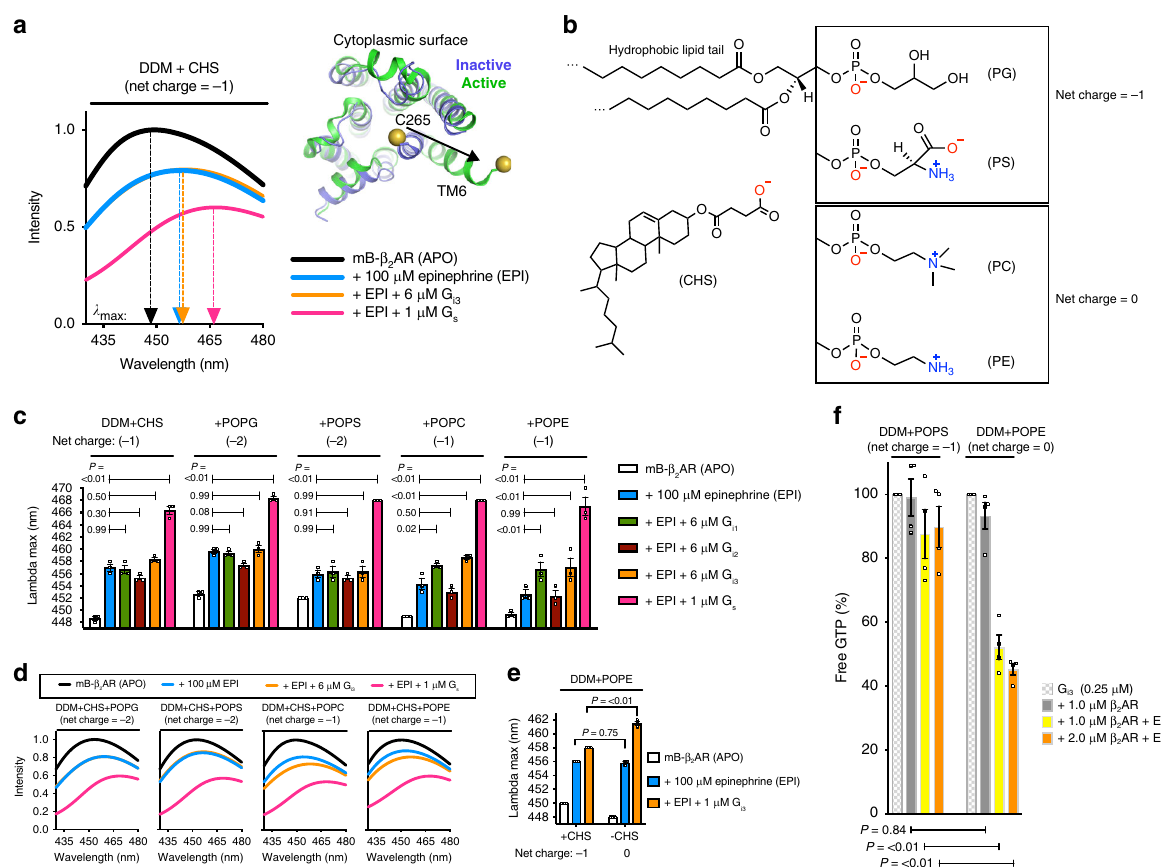
Fig. 1 Negatively charged lipids inhibit β 2 AR − G i coupling in detergent. a mB − β 2 AR emission spectra in DDM + CHS micelles (5:1 DDM:CHS mole ratio) in the absence of epinephrine (APO) and in the presence of epinephrine, ± G protein (G s or G i3 ). Arrows point to the lambda max value, i.e. the wavelength where mB emission intensity is greatest. Inset shows how G s coupling alters the structure of mB − β 2 AR, highlighting the change in position of monobromobimane (mB) at C265 of transmembrane 6 (TM6) (Inactive: PDB 5JQH 74 ; Active: PDB 3SN6 69 ). b Structures of CHS and phospholipids, with net charge indicated. c Effect of phospholipid on mB − β 2 AR interaction with G protein (G i1 , G i2 , G i3 , and G s ), read out as an increase in lambda max. Interaction was assessed in the absence of lipid (5:1 DDM:CHS mole ratio) and in the presence of POPG, POPS, POPC, or POPE (5:1:1 DDM:CHS:Lipid mole ratio). Multiplicity adjusted P values were computed by two-way ANOVA followed by Dunnett ’ s post hoc test between indicated groups. d Selected mB − β − β μ M G 2 AR emission spectra from panel ( c ). e Effect of CHS on mB 2 AR interaction with 1 i3 . Interaction was assessed in the presence of CHS